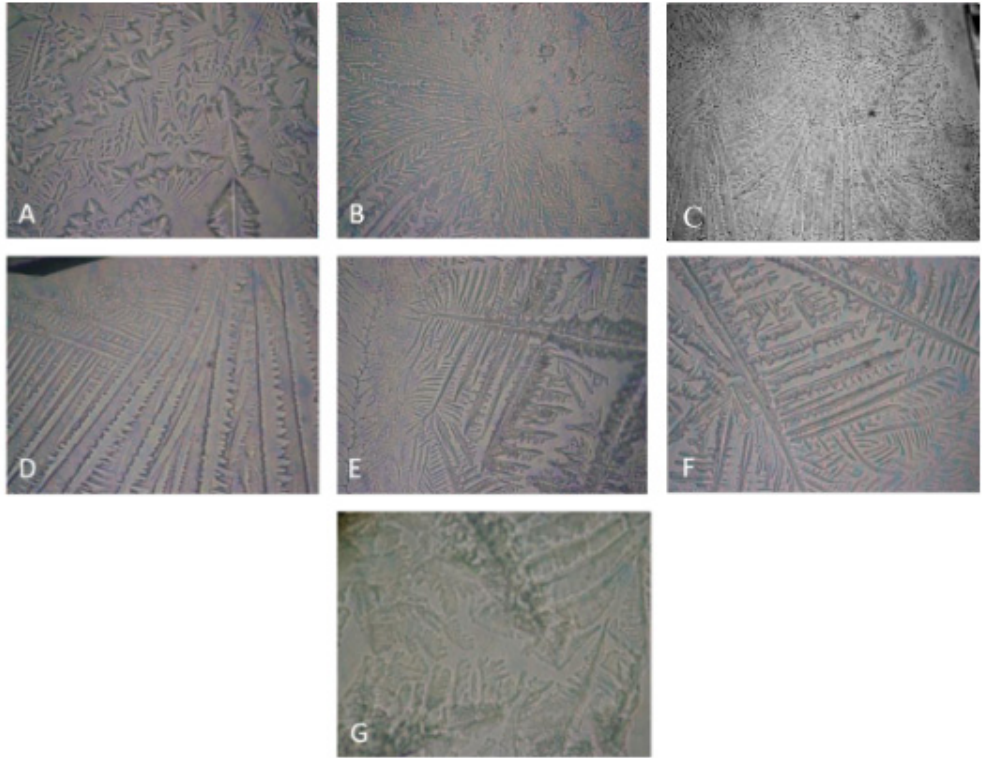
Figure 1. Ferning patterns observed after evaporation of microdroplets of mucomimetic polymers (MMP) solutions. ( A ) CHA 0.001%, ( B ) CHA 0.01%, ( C ): HA 0.01%, ( D ) HA 0.1%, ( E ) CMC 0.01%, ( F ) CMC 0.1%, ( G ): GG 0.05%. The field of view is 0.8 mm × 0.8 mm.